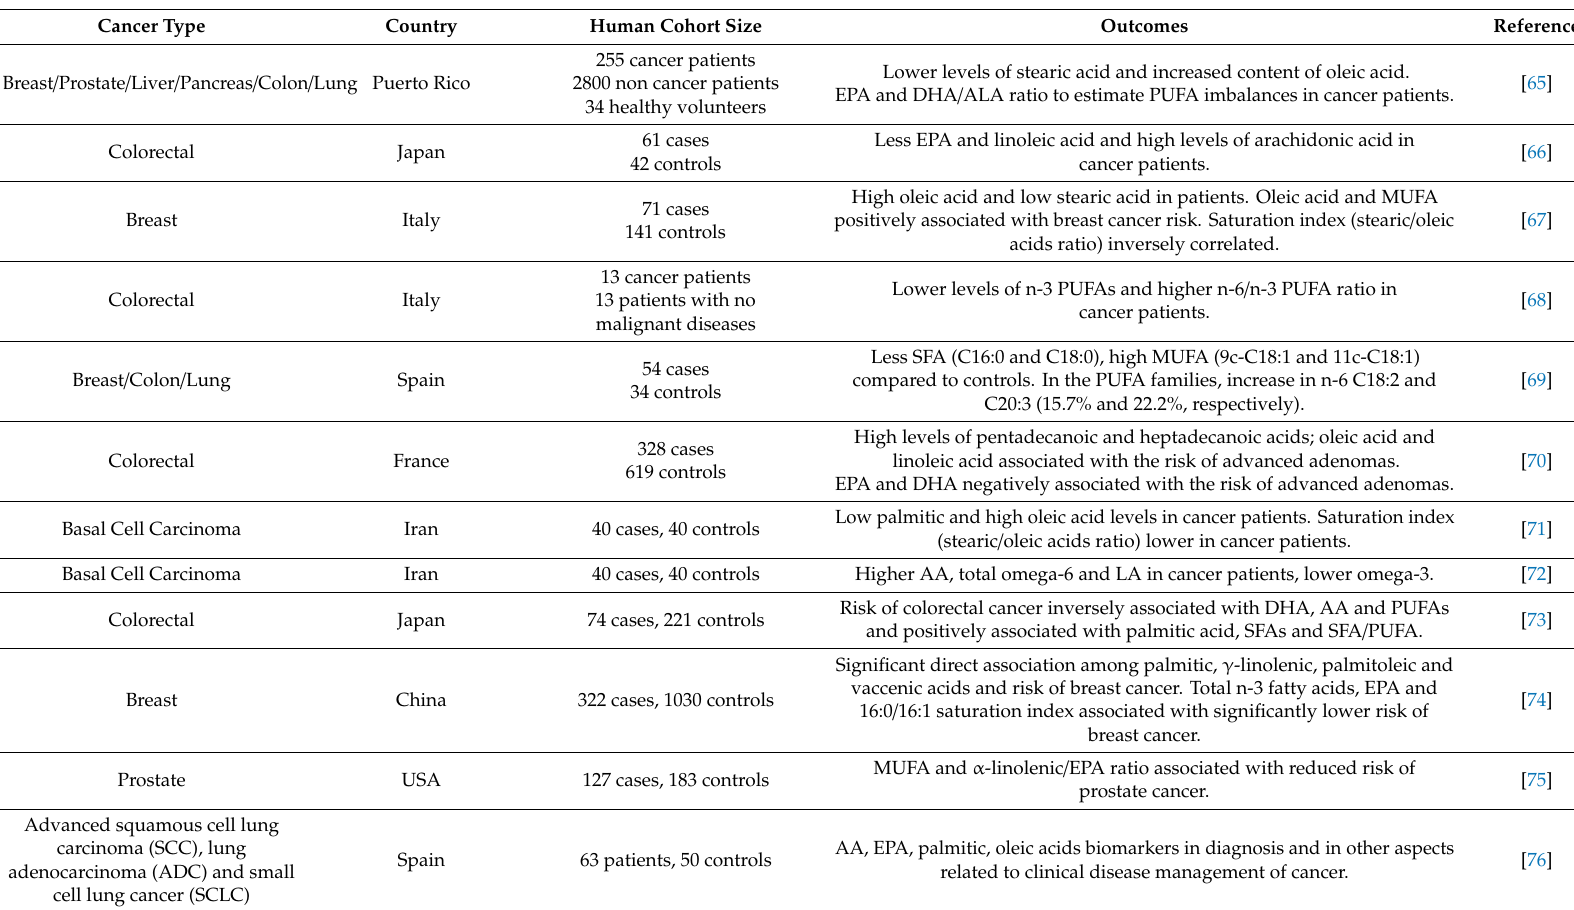
Table 2. Fatty acids in cancer: collection of data from studies on erythrocyte membrane fatty acids in patients a ff ected by di ff erent types of cancer and emerging